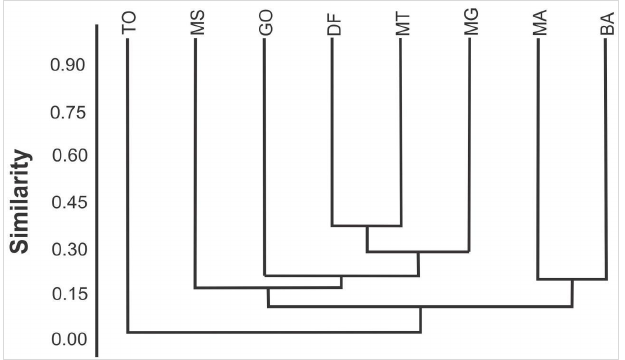
Fig 2 . Dendrogram drawn from the similarity Jaccard index among known areas, based on data from species of the Mischocyttarus